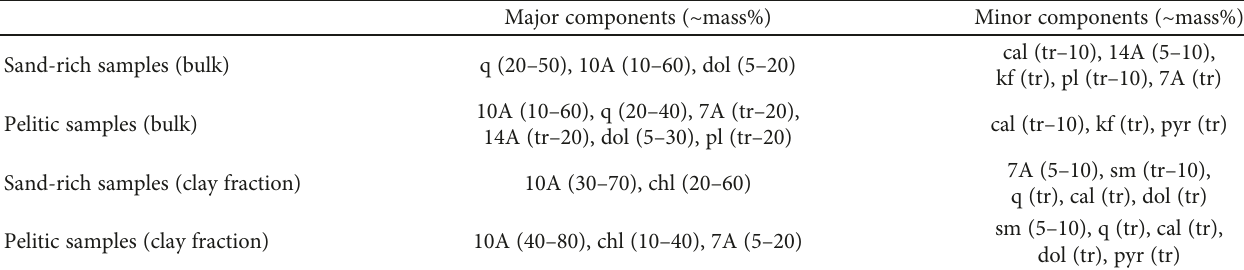
Table 1: Mineralogical composition of the studied bulk rock samples and separated clay fractions.